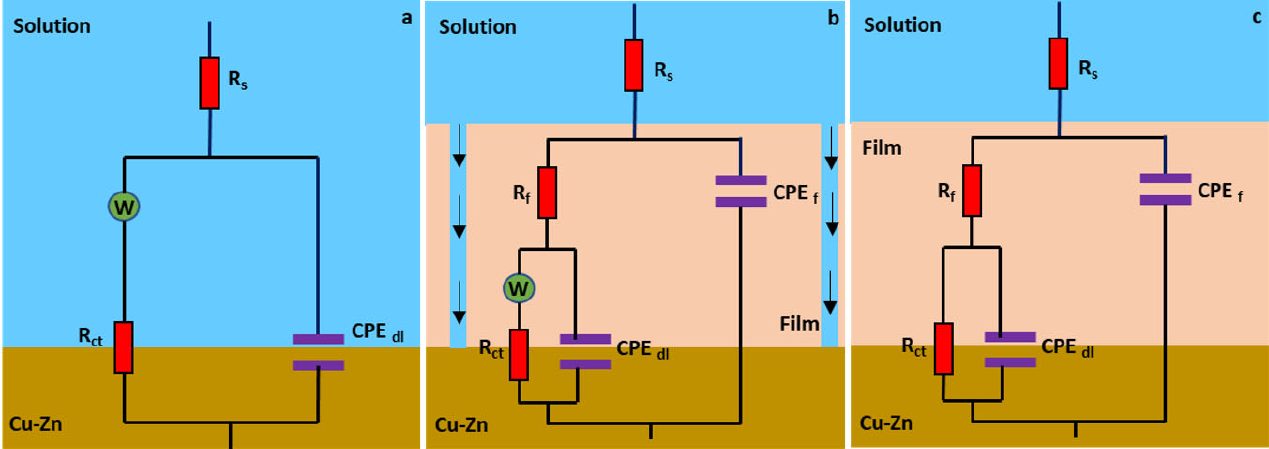
Table 3. Impedance parameters obtained by fitting EIS data using Zview software for the blank and in the presence of different concentrations of corrosion inhibitors.